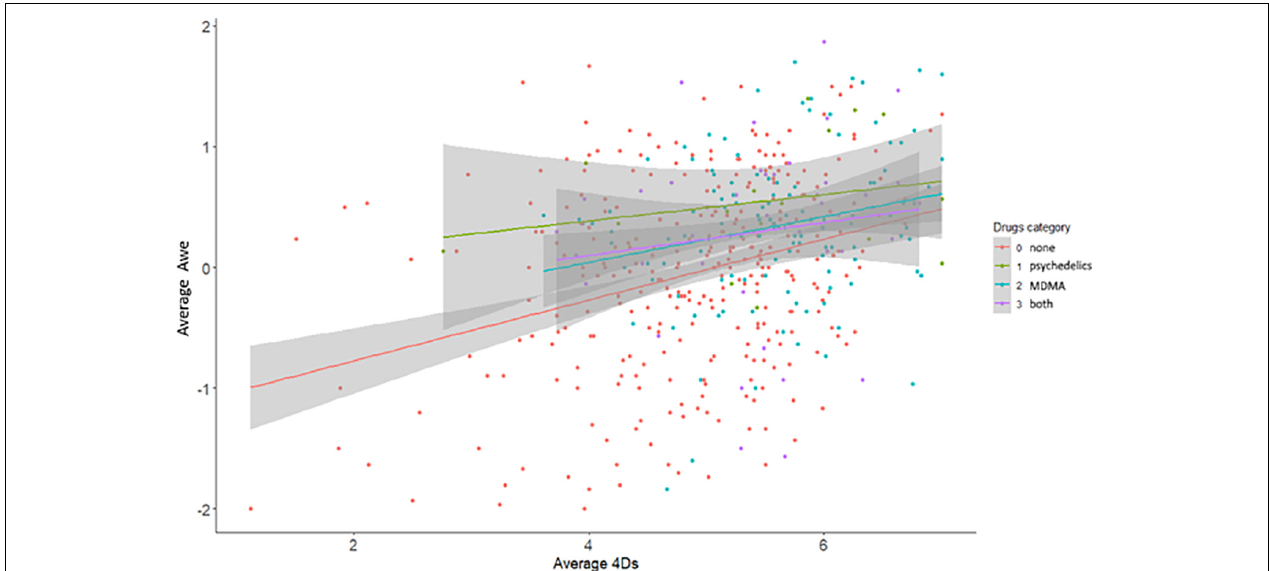
FIGURE 3 | Scatterplots of the effect of the 4Ds on awe, grouped by drugs taken during the rave.